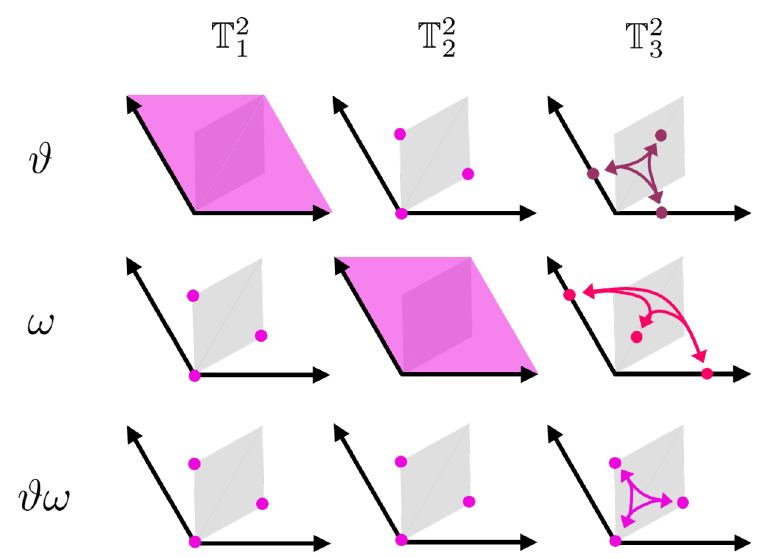
Figure 9 . Illustration of the fixed point structure of the orbifold class Z 3 × Z 3 − 1 − 2 . The fixed points are divided into three groups, according to their constructing element ( ϑ , ω , ϑω ), and represented by their location in the respective torus (pink, red, and purple). Arrows between fixed point locations indicate